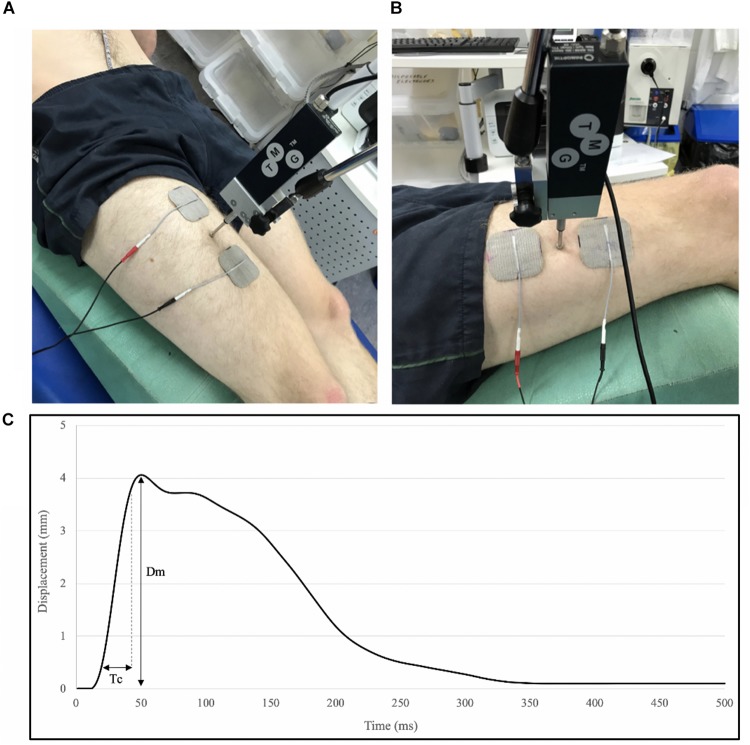
Tensiomyography set-up for measurement of the Rectus femoris (RF) (A) and the VL (B), and parameters extracted from a typical TMG trace; displacement (Dm) and contraction time (Tc) between 10% and 90% of Dm (C). Electrode and stimulator position were recorded with reference to anatomical landmarks and replicated in post-intervention measures.